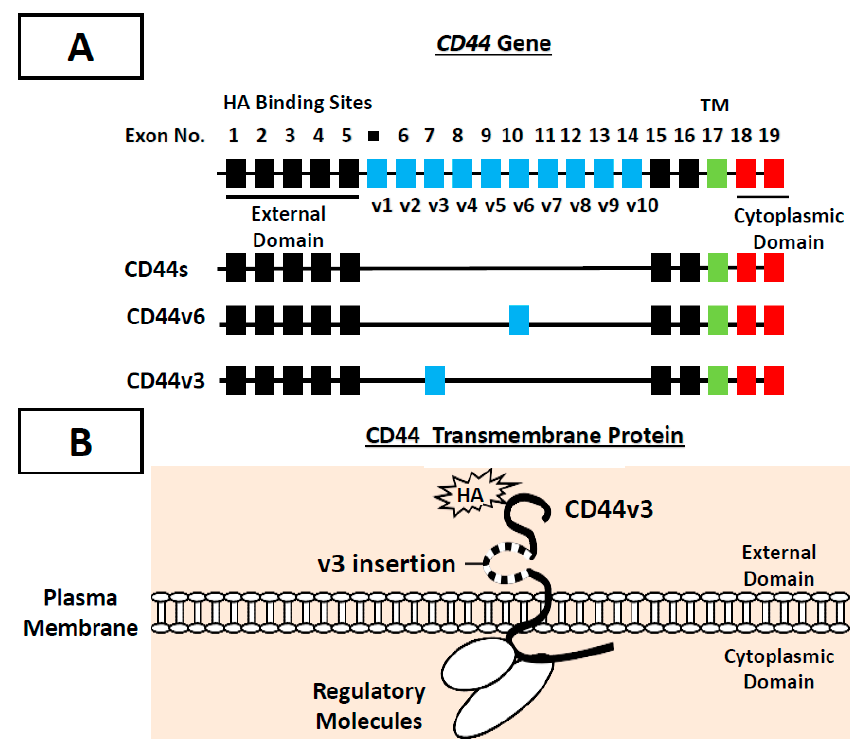
Figure 2. Illustration of CD44 gene and alternative spliced variants (e.g., CD44v3 and CD44v6 isoforms) which contain several structural domains including external domain, transmembrane (TM) and intracellular domain ( A ); and demonstration of CD44v3 protein which displays the HA binding domain at the external N-terminal region and the signaling regulator binding sites at the cytoplasmic domain ( B ).